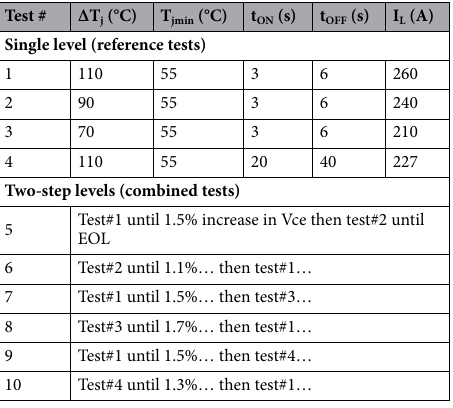
Table 1. Reference tests (single level) and sequenced tests (two-step levels)